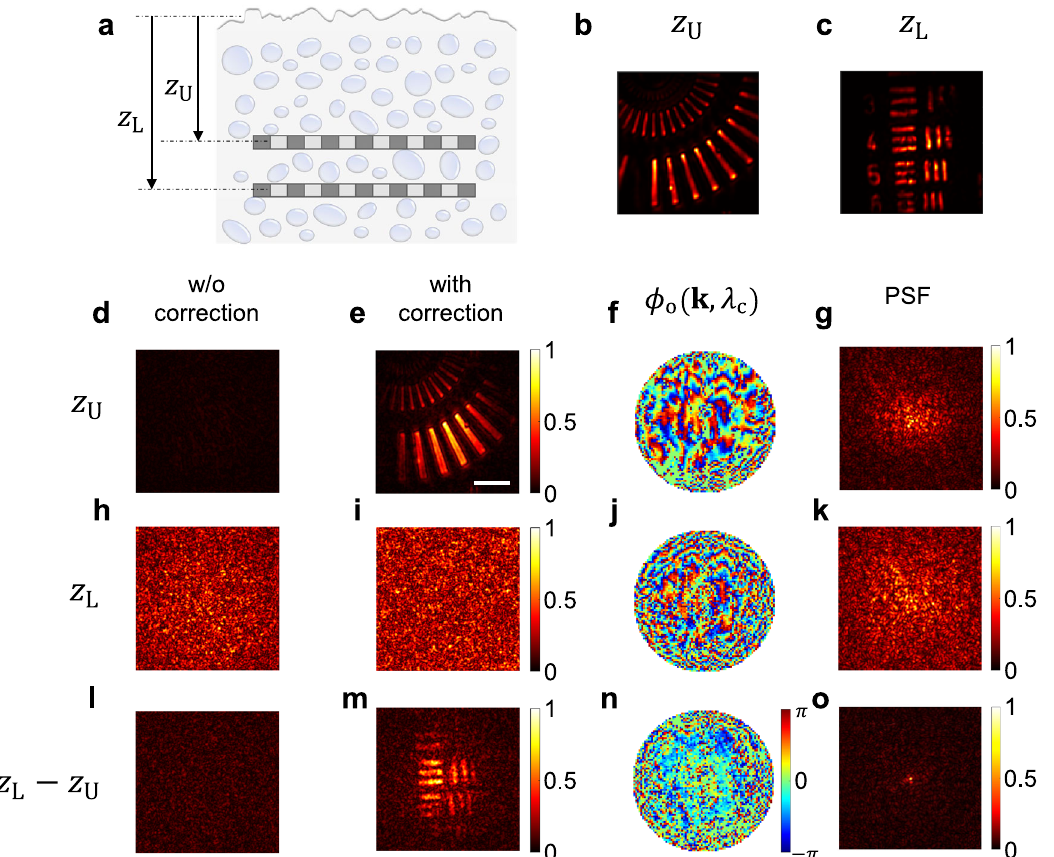
Fig. 5 | Progressive depth imaging. a Layout of bilayer sample. Siemens star-like spread-function, respectively. h , i Same as d and e , but of lower layer. Color bar, normalized i ntensity by the maximum intensity at i . j , k Same as f , g , but of lower target ( b ) and USAF target ( c ) embedded in scattering medium 80 μ m apart in layer. l , m Sameas h , i ,butafterapplicationofspectro-angulardispersionofupper depth. The aberration medium is placed above the sample. b , c Ground-truth layer.Color bar, normalized intensitybythe maximum intensity at m . n , o Same as images for each target. d , e Coherence-gated confocal images of the upper layer, (cid:1) (cid:3) E z z f and g , but after application of spectro-angular dispersion of upper layer. Color , before and after dispersion correction, respectively. Color bar, ccg r , t = U bars in g , k , and o : normalized intensity by the maximum intensity in each image. normalized intensity by the maximum intensity at e . Scale bar, 10 μ m. f , g Output (cid:1) (cid:3) Color bar in n : phase in radians for f , j , and n at center wavelength and its point- angular dispersion of upper layer, ϕ U o k , λ c